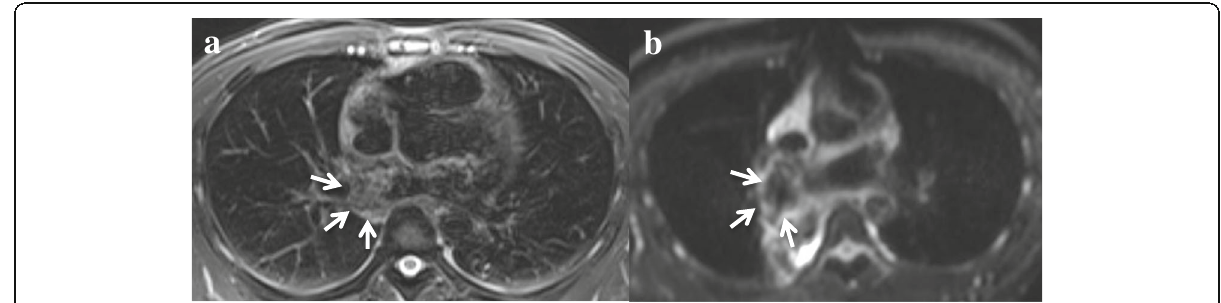
Fig. 4 Local recurrence on magnetic resonance imaging (MRI). a At 7 months after surgery, before proton beam radiotherapy, recurrent tumor shadow was detected (arrows). b After proton beam radiotherapy, the tumor shadow was hardly detected (arrows)